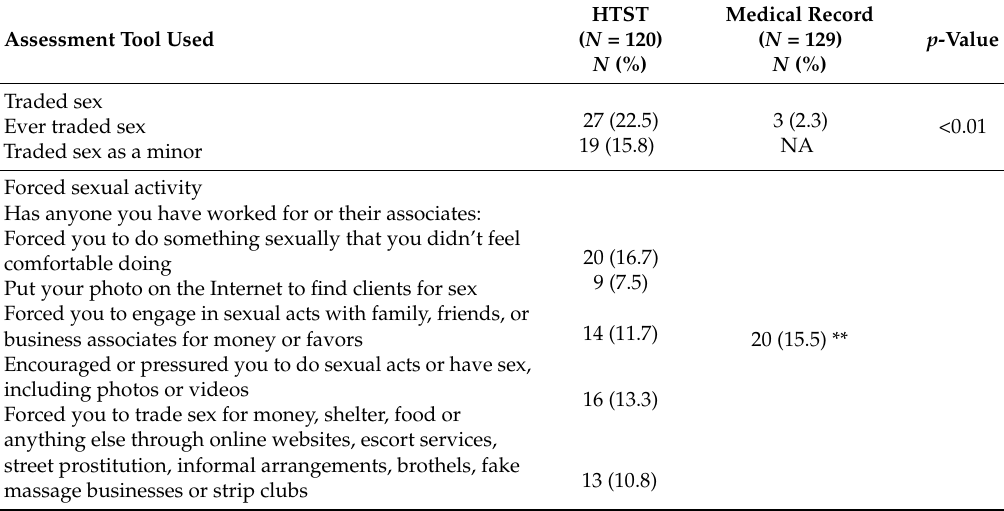
Table 2. Details of sexual exploitation * identified using the Human Trafficking Screening Tool (HTST) versus medical record review.